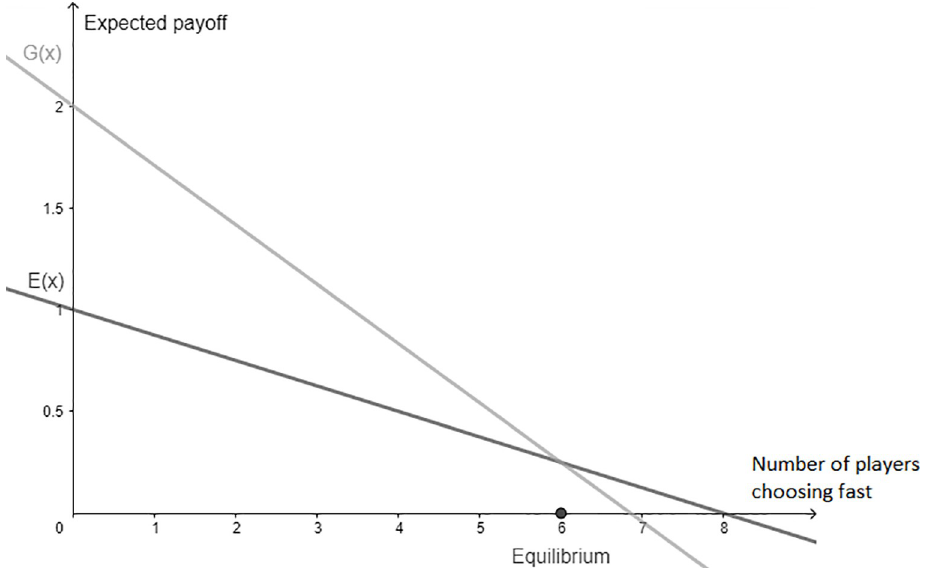
Fig 1. Expected payoff of choosing fast, G(x), and of choosing slow, E(x), depending on the number of players (x) in a group that chose fast.